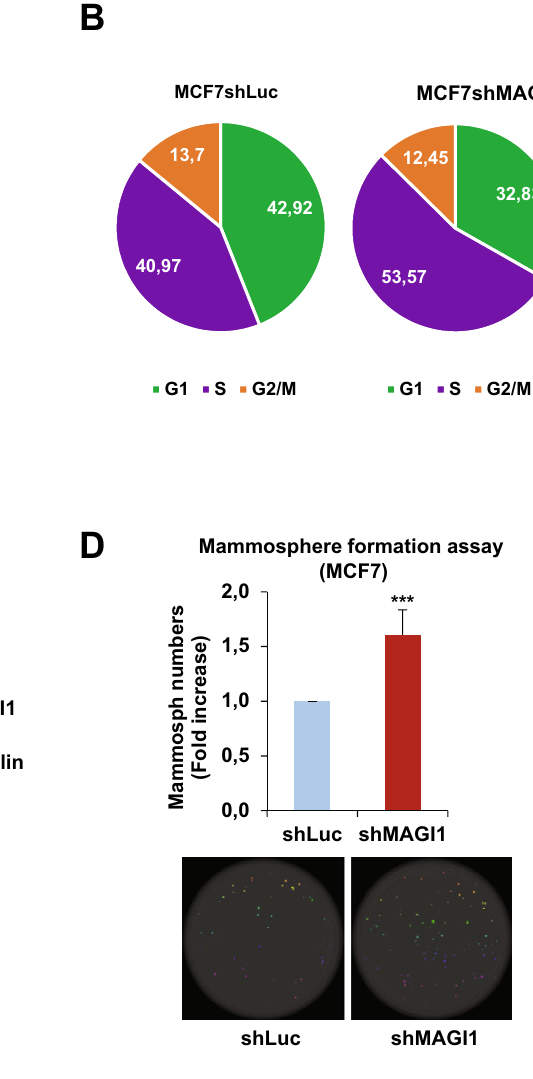
Figure 1. MAGI1 impairment induces tumorigenic phenotypes in epithelial cells. ( A ) MTT assay (OD 560 nm) representing 2D cell growth of MCF7 shMAGI1 as compared to MCF7 shLuc cells. Bars represent mean ± Standard Deviation (SD; n = 10 wells as replicates) of a representative experiment (out of 3). Unpaired two-tailed Student’s t-test; ** p < 0.01; *** p < 0.001. ( B ) Cell cycle phases of MCF7 shLuc and MCF7 shMAGI1 cells assessed after BrdU incorporation and analyzed by flow cytometry, showing an increased proportion of cells in S phase at the expense of G0/G1 after MAGI1 invalidation. The pie chart also showed no major difference in the percentage of apoptotic cells in SubG1 phase (around 2% in shLuc and 1% in shMAGI1 cells). ( C ) Left: quantification of colony numbers of MCF7 shMAGI1 cells grown in anchorage independent conditions (soft agar assay) and represented as fold increase compared to MCF7 shLuc cells. Data are presented as the means ± SD (n = 3). Unpaired two-tailed Student’s t-test; *** p < 0.001. Right: western blot analysis of whole protein extracts issued from the cells used in the soft agar assays and showing the relative amounts of MAGI1 in the different cell lines; Tubulin was used as a loading control. Uncropped blots can be found in the Supplementary Information. ( D ) Top: quantification of mammospheres represented as total area issued from MCF7 shMAGI1 cells and shown as fold increase compared to MCF7 shLuc cells, starting from 200 cells. Data are presented as the means ± SD (n = 4). Unpaired two-tailed Student’s t-test; *** p < 0.001. Bottom: images of mammosphere formation assay showing a representative